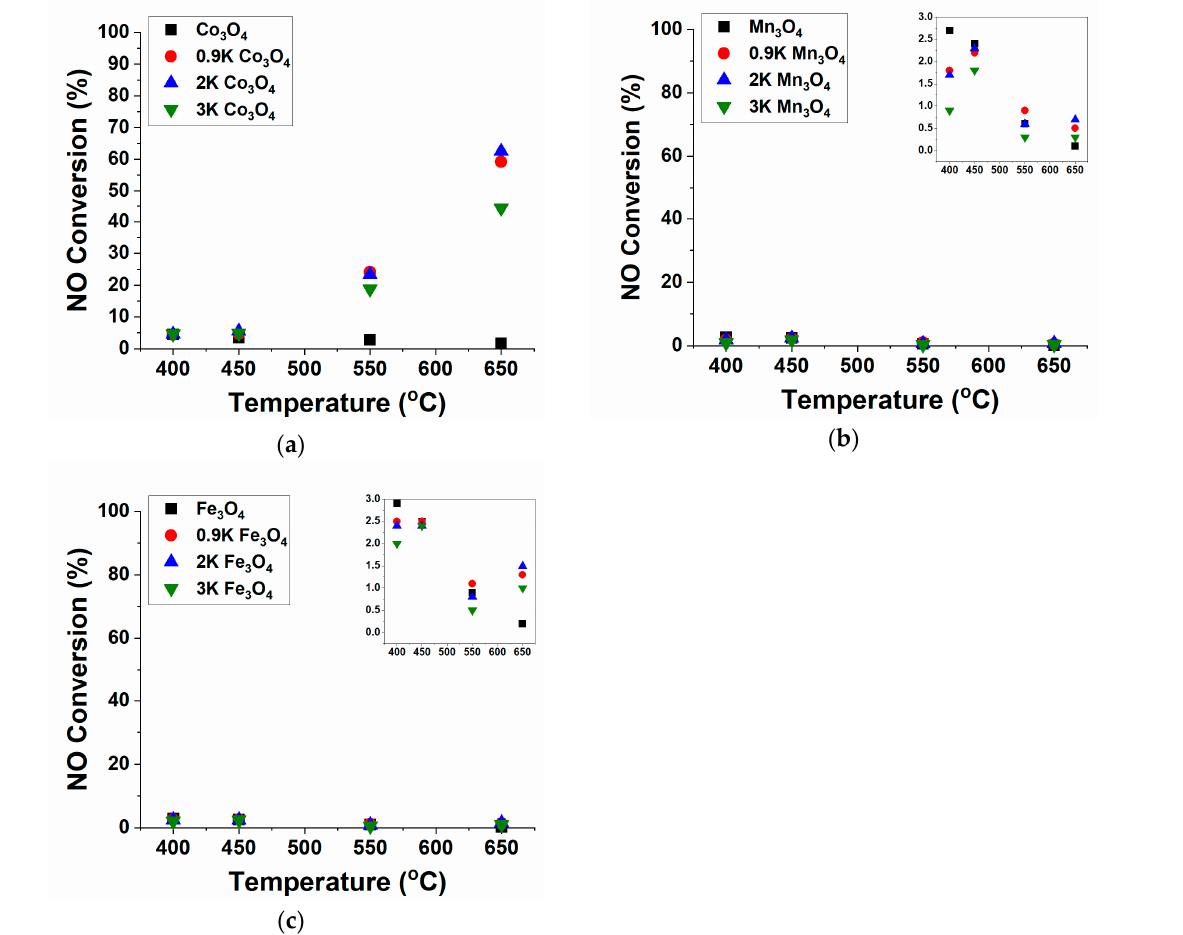
Figure 1. NO conversion as a function of temperature over ( a ) Co 3 O 4 -based catalysts, ( b ) Mn 3 O 4 -based catalysts, and ( c ) Fe 3 O 4 -based catalysts with varying K promotion (0–3 wt.% K); insets for ( b ) and ( c ) present the low NO conversion region (0–3%) as a function of temperature to magnify small changes in conversion.